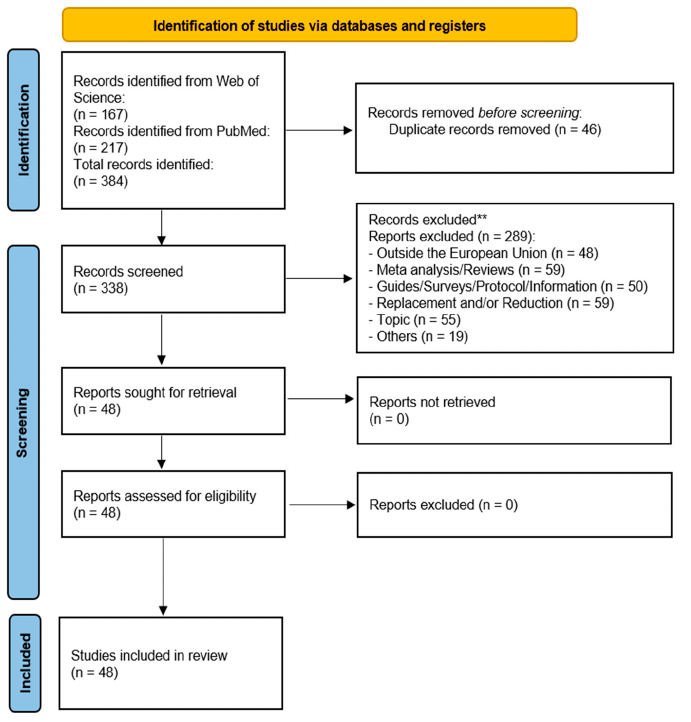
Figure 1. PRISMA flowchart of study selection. Table 1. Classification of the studies by category and